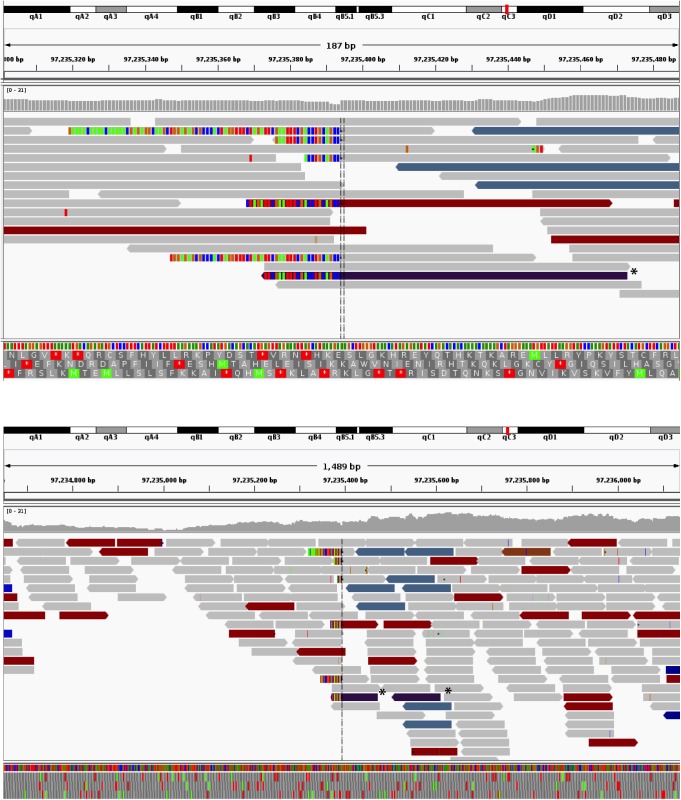
Transgene integration site for F9.Adapted from the screenshots from the IGV genome viewer show the integration sites of the transgene in chromosome 10. The colored reads indicate that the other half of the fragment maps discordantly. The teal colored reads are those that have mates on the transgene, and the purple reads (asterisked) on chr17 (the homologous segments to the transgene material, which are ambiguous for mapping purposes). Multi-colored segments at the ends of reads highlight soft-clipped portions of reads. There is a single cluster of soft-clipped reads for the F9 insertion site.